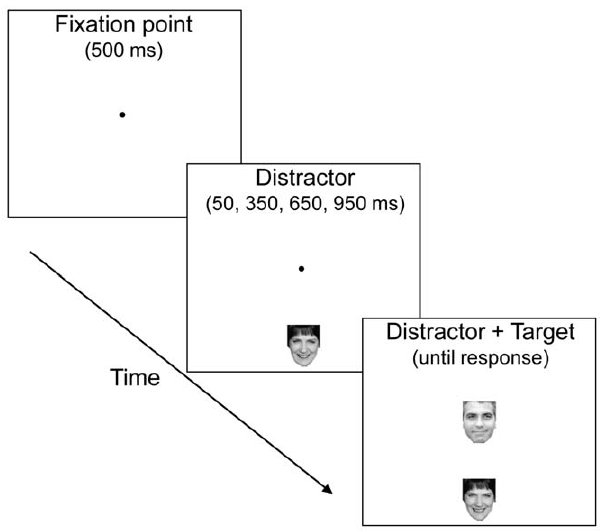
Figure 1. Trial sequence. A distractor appeared above or below fixation at random and was either the same as (compatible) or different than (incompatible) a subsequent central target. The distractor and the target were both either upright or inverted, depending on the version. Participants identified the central target on all trials by pressing one of two